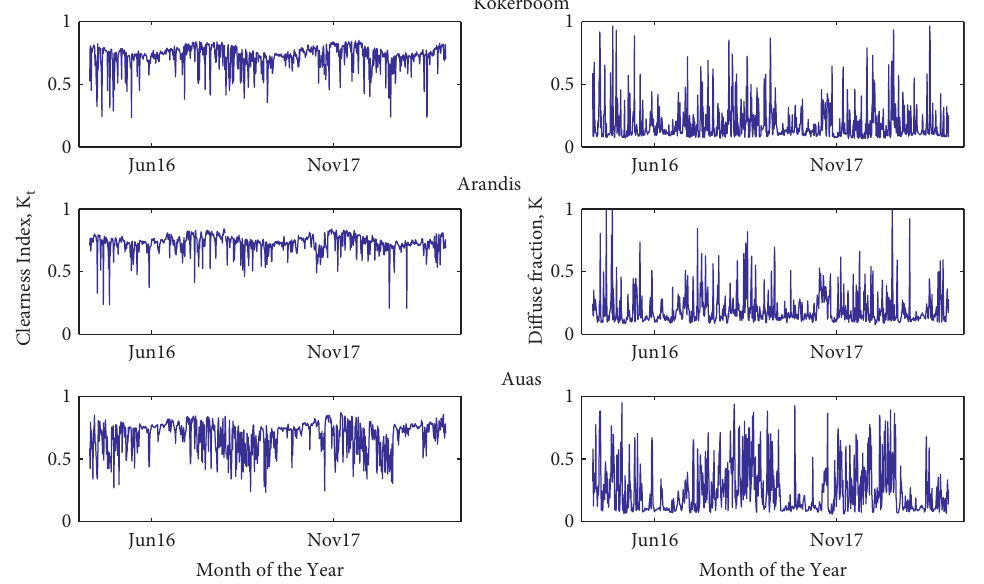
Figure 1: Daily variation of clearness index and diffuse fraction at the three measurement sites.